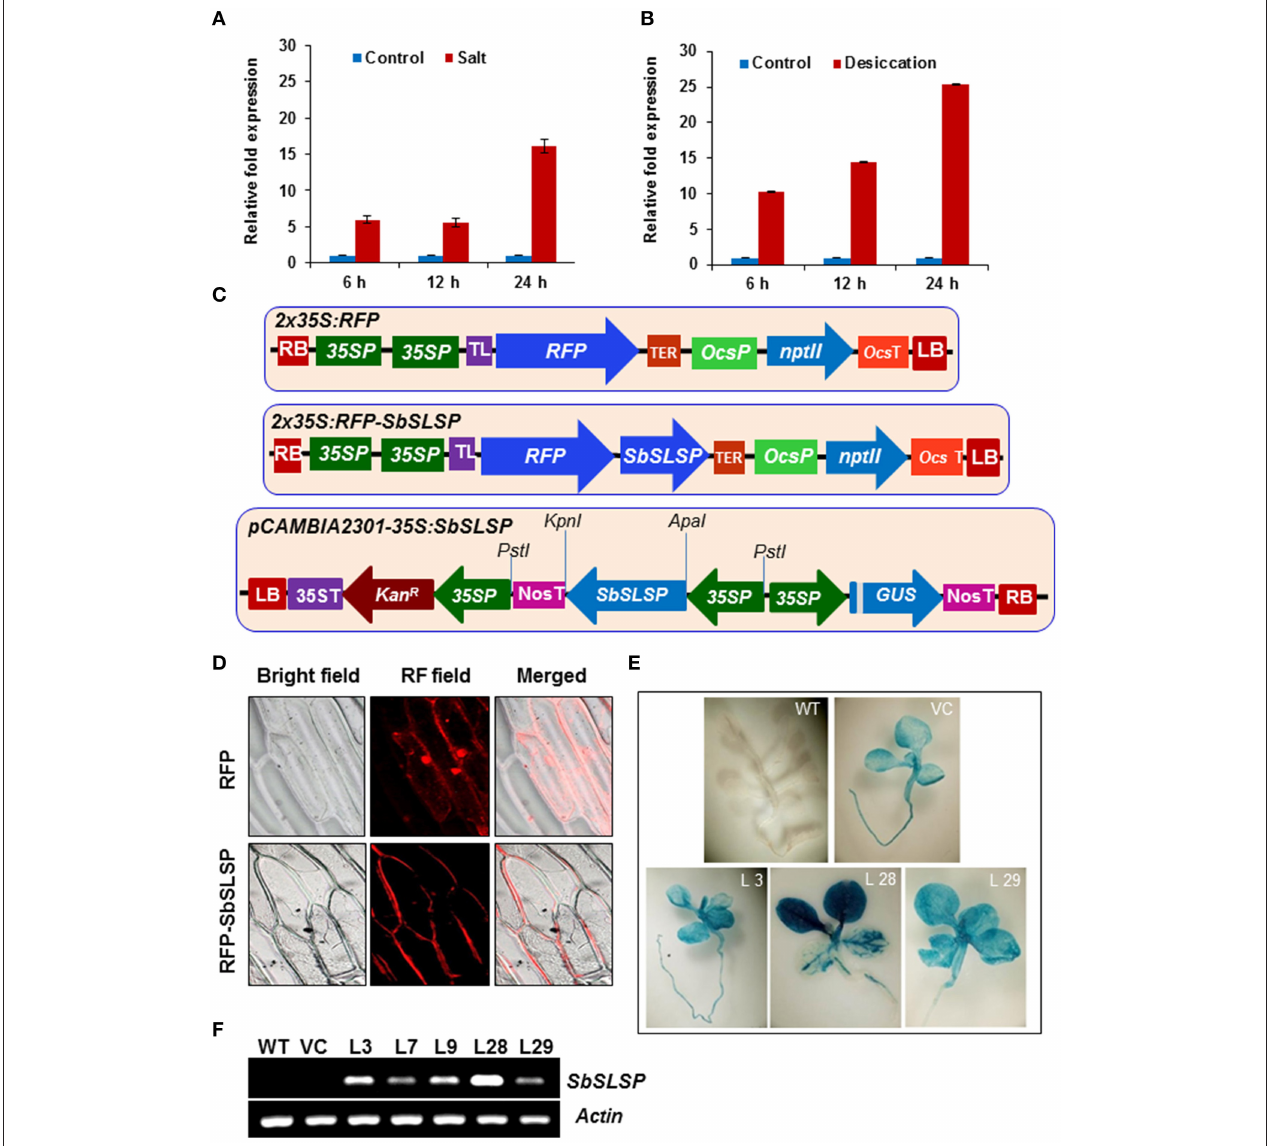
FIGURE 1 | Expression, localization and molecular analyses of SbSLSP –overexpressing transgenic tobacco plants. (A,B) Expression pattern of SbSLSP in response to salt and desiccation stress treatments for different time periods in Salicornia brachiata . The relative fold expression of SbSLSP in stressed and non-stressed conditions was calculated using the 2 − 11 cT method. Values are means ± SD from three independent measurements. (C) Schematic representation of the pSITE-3CA-2X35S:RFP:SbSLSP construct ( RFP:SbSLSP ) used for transient expression and pCAMBIA2301-35S:SbSLSP construct used to transform tobacco plants with the SbSLSP gene. (D) SbSLSP resides in the plasma membranes of onion epidermal cells. Cells with constructs expressing red fluorescence protein (RFP) alone and the RFP:SbSLSP fusion protein were analyzed using a bright and red fluorescence field microscope. (E) GUS assay of T 2 seedlings showing positive GUS expression in the transgenic lines. (F) Transcript levels of the SbSLSP gene in transgenic lines and WT T 2 plants via semi-quantitative